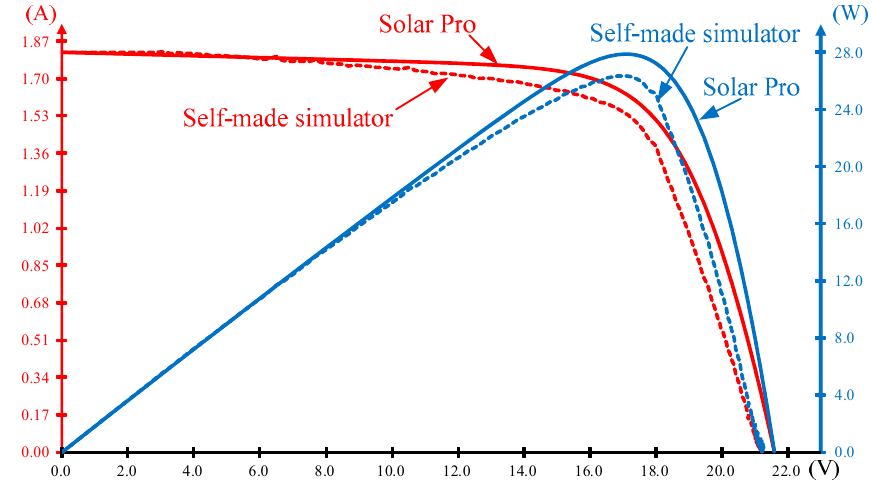
Figure 11. I-V and P-V characteristic curves of Solar Pro simulation and self-made simulator under 0% shading.